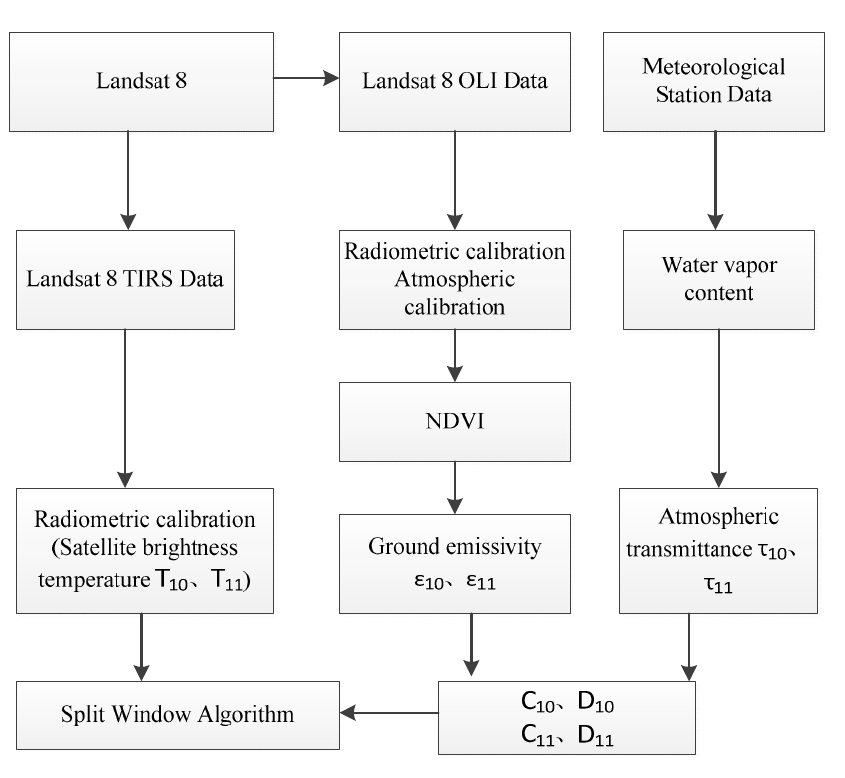
Figure 3. Flow chart of the split window algorithm.